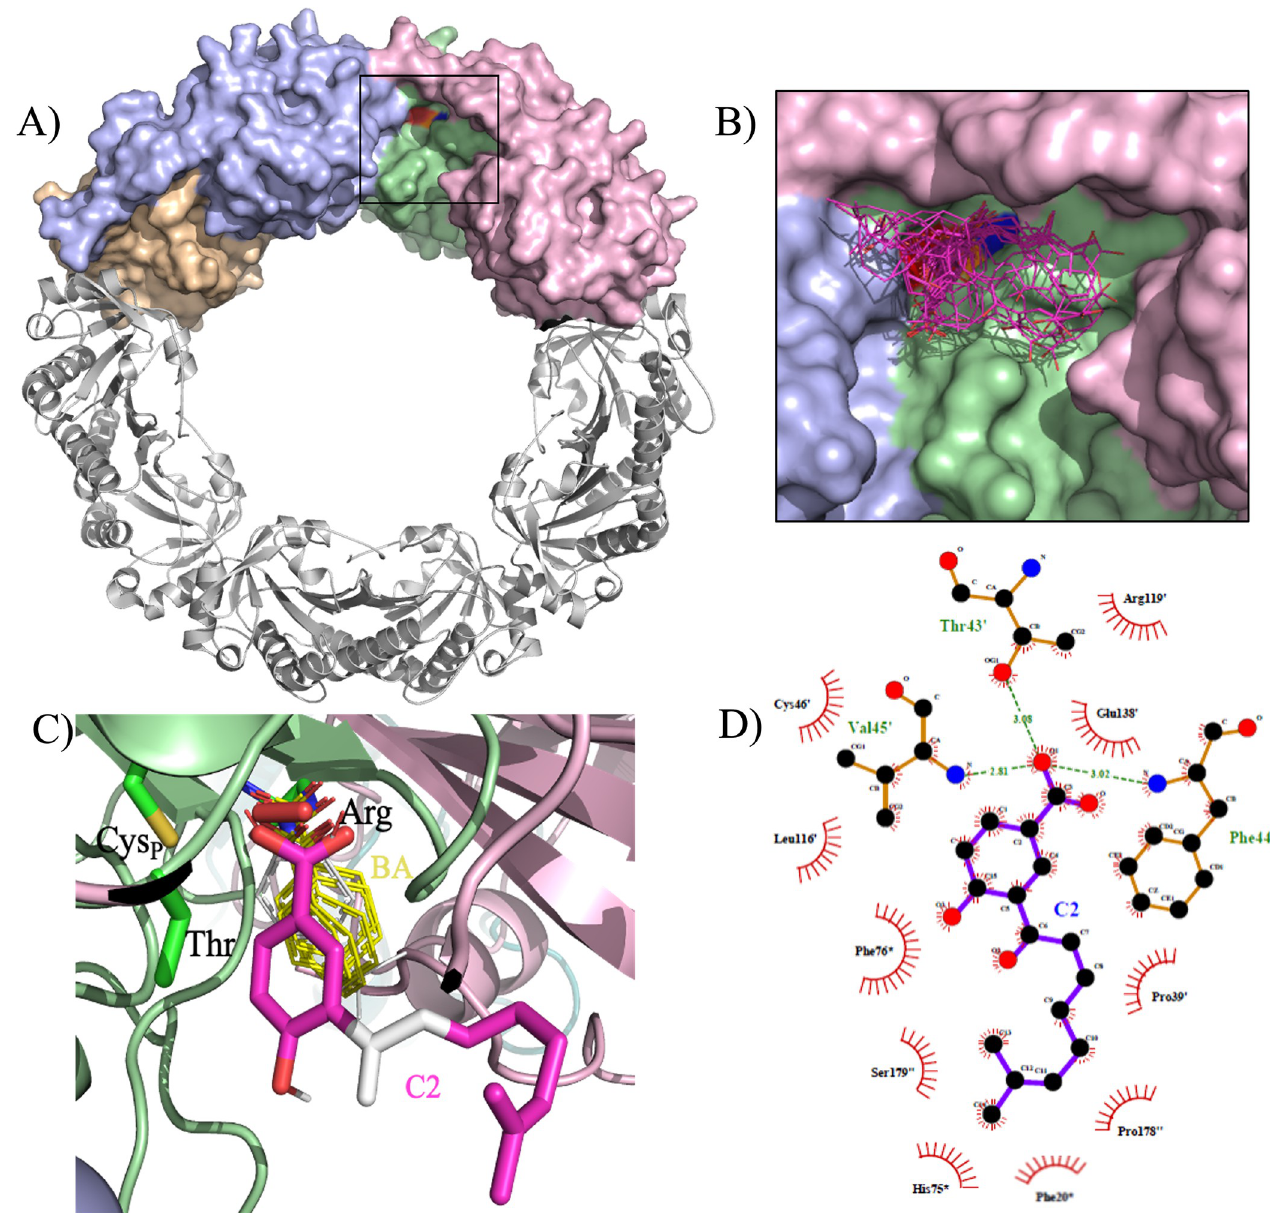
Fig 9. Decameric structure of AhpC and docking results and best pose selection based in peroxiredoxin ligands found in pdb database. ( A ) S . typhimurium AhpC (PDB = 4MA9) in reduced decameric state. The enzyme is composed by five obligate homodimers and the two upper homodimers are represented by molecular surface and colored in purple/beige and green/pink. The other dimers of the decamer are represented in cartoon and colored in light gray. The black box denotes the active site microenvironment located at the dimers interface. The catalytic triad residues Thr, Cys P and Arg are colored in red, orange and blue, respectively. ( B ) Molecular docking results for compound C2 . The molecules cluster of the compound C2 are represented by lines and colored in pink. ( C ) Superposition of the compound C2 best hit to StAhpC with ligands found in Prx structures deposited in the pdb database: H 2 O 2 (PDB code = 3A2V; color = red), benzoate (2V32; 1HD2; 1OC3; 2V41; 1H4O; yellow) and tert-butylbenzene-diol (4K7O; white). The C2 is colored in pink with the atoms of α , β -unsaturated carbonyl system highlighted in white. The other molecules are represented in lines with different colors. The oxygens are in red. The catalytic triad (Thr, Cys P and Arg) is represented by sticks. (D) Diagram of interacting residues of AhpC with compound C2 docked in the StAhpC active site. The dashed green lines represent hydrogen bonds and hydrophobic contacts are represented by red arcs with radiating spikes. The binding analysis was performed using the LigPLot +